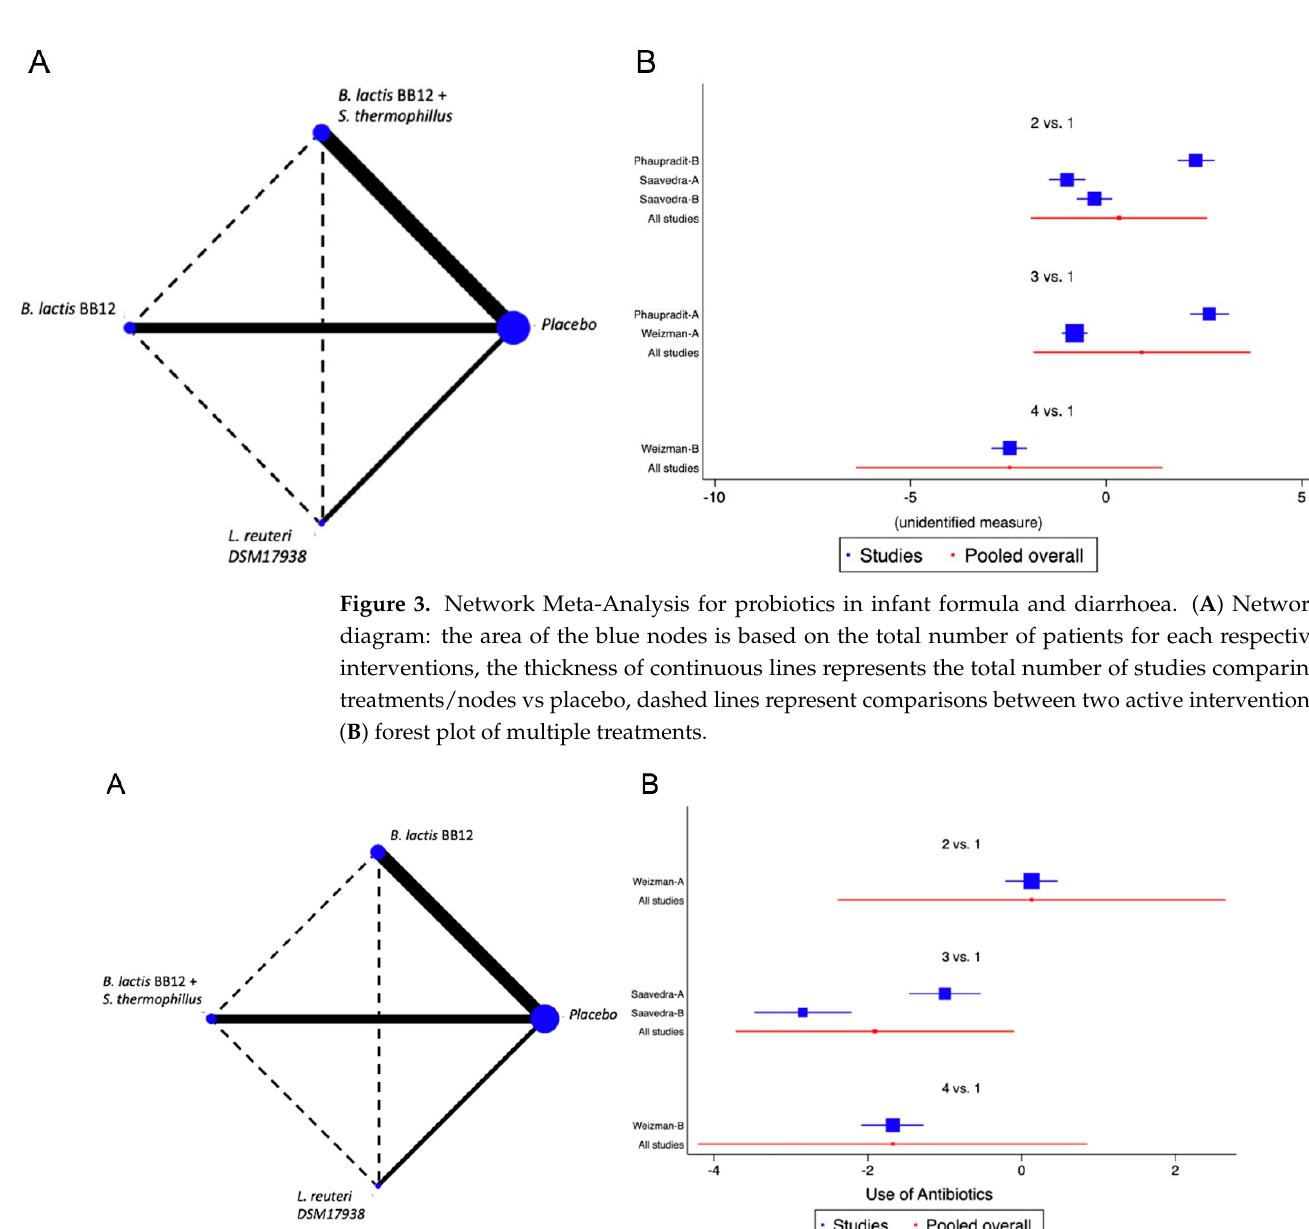
Figure 5. Network Meta-Analysis for probiotics in infant formula and change on weight/height Z score. ( A ) Network diagram: the area of the blue nodes is based on the total number of patients for each respective interventions, the thickness of continuous lines represents the total number of studies comparing treatments/nodes vs placebo, dashed lines represent comparisons between two active interventions; ( B ) forest plot of multiple treatments.